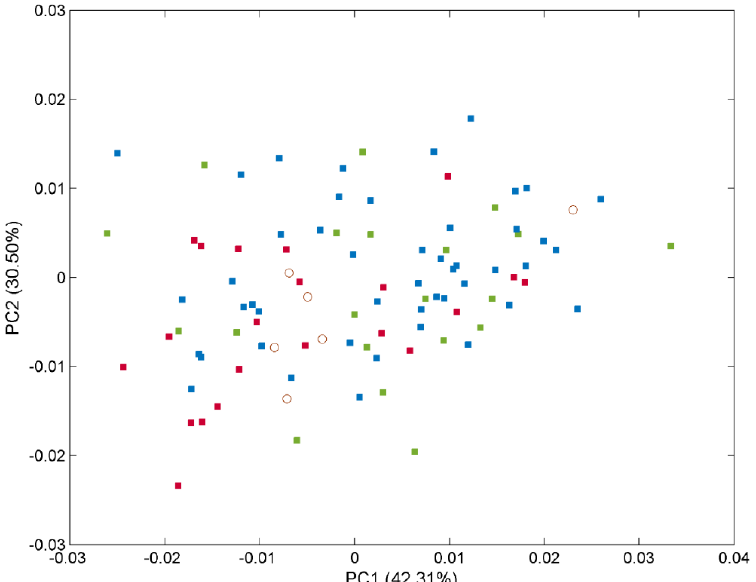
Figure 2. Scores for the plasma samples from the 97 patients (full data set) on the first 2 principal components explaining the variability in the IR spectral data. The samples are labelled according to their specific pathology: healthy control ( ), PD ( ), and AD ( ) subjects and external test samples ( ). Table 1. Percentages of correctly classified samples/patients in both classification and internal/external val- idation corresponding to the SELECT-LDA performed when addressing the global classification